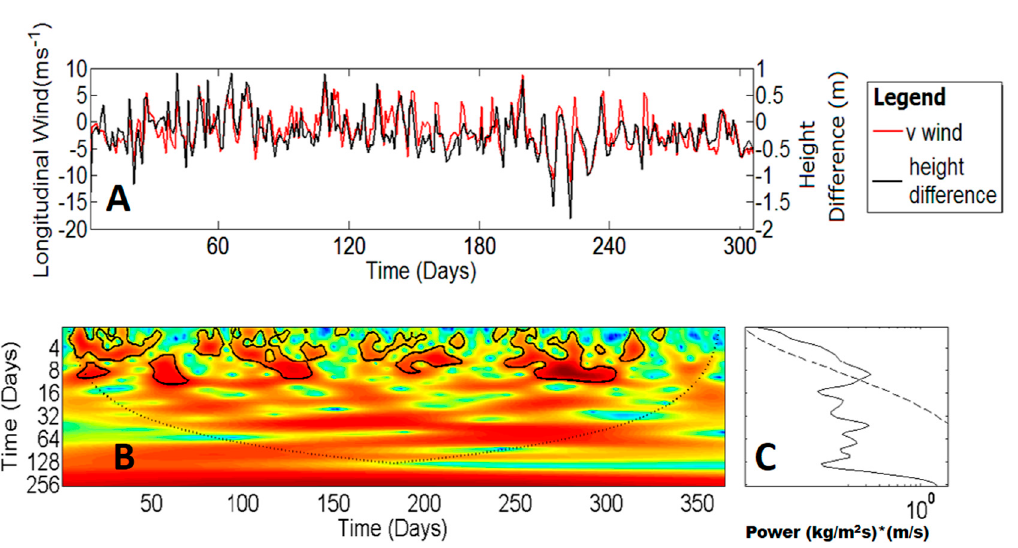
(black line) and measured longitudinal component of the wind (red line) used for the cross-wavelet